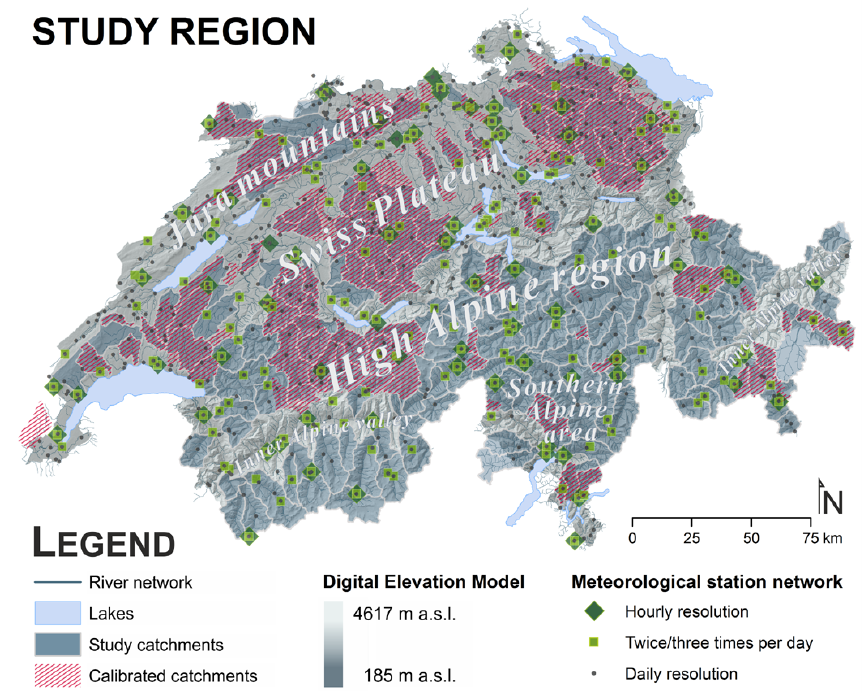
Fig. 1. Overview of the study region. Note that the study catchments (white borders) and the calibrated catchments are partly superimposed. The calibrated catchments are located within the red hatched areas, but their watershed boundaries are not delineated to enhance